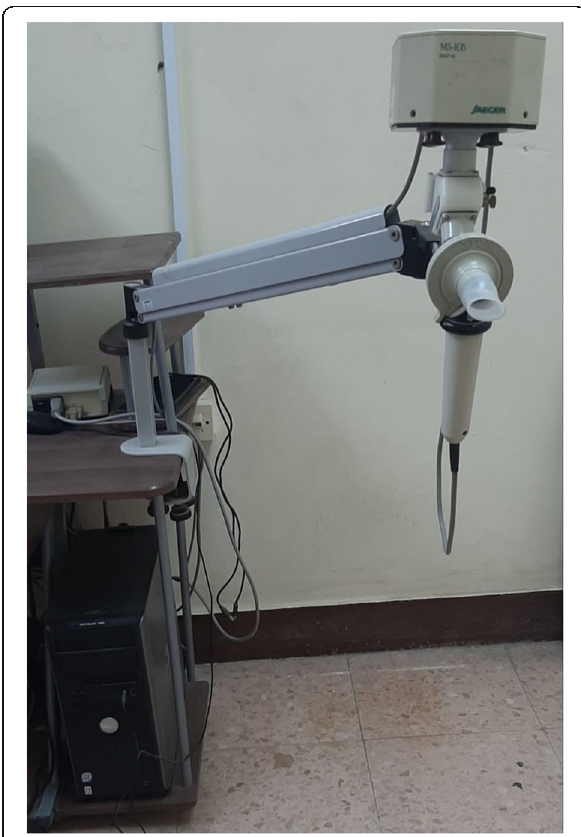
Fig. 1 VIASYS Healthcare GmbH. Leibnizstrasse 7, spirometry and impulse oscillometry